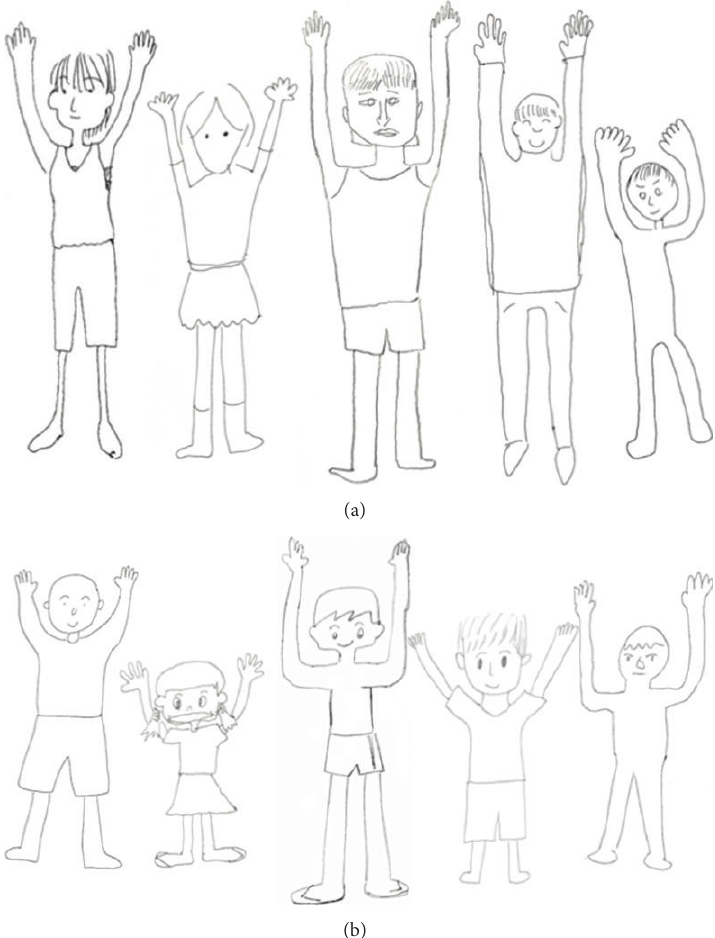
Figure 2: Examples of human figure drawings for each patient group. (a) Human figure drawings (hands-up) of five patients who drew six- fingered hands (from the left): HK, IM, MM, ST, and SY. (b) Human figure drawings (hands-up) of five-fingered hands (from the left): ANY, AY, HE, KH, and KM.